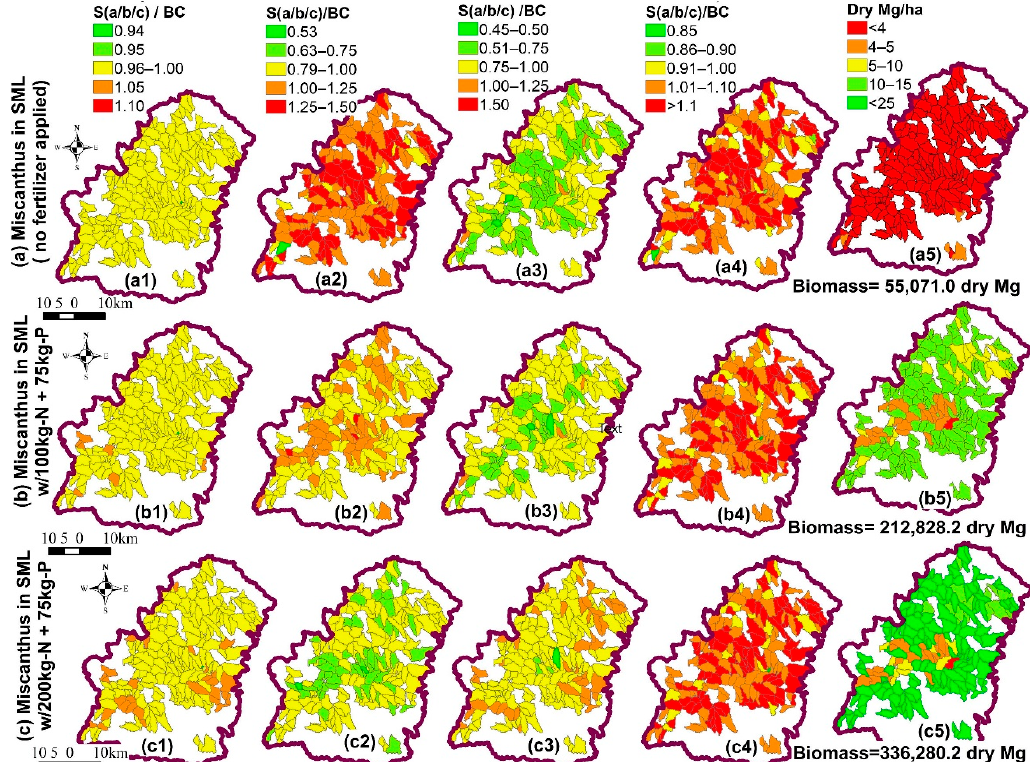
Figure 8. Impact of growing energy crops (i.e., miscanthus) in SML on watershed performances and potential of annual biomass availability considering different scenarios (no ( a ) / low ( b ) / high ( c )) of nitrogen application (BC: Base case; 1 : Water yield, 2 : Sediment, 3 : Nitrate, 4 : Phosphorous, and 5 : Biomass yield).